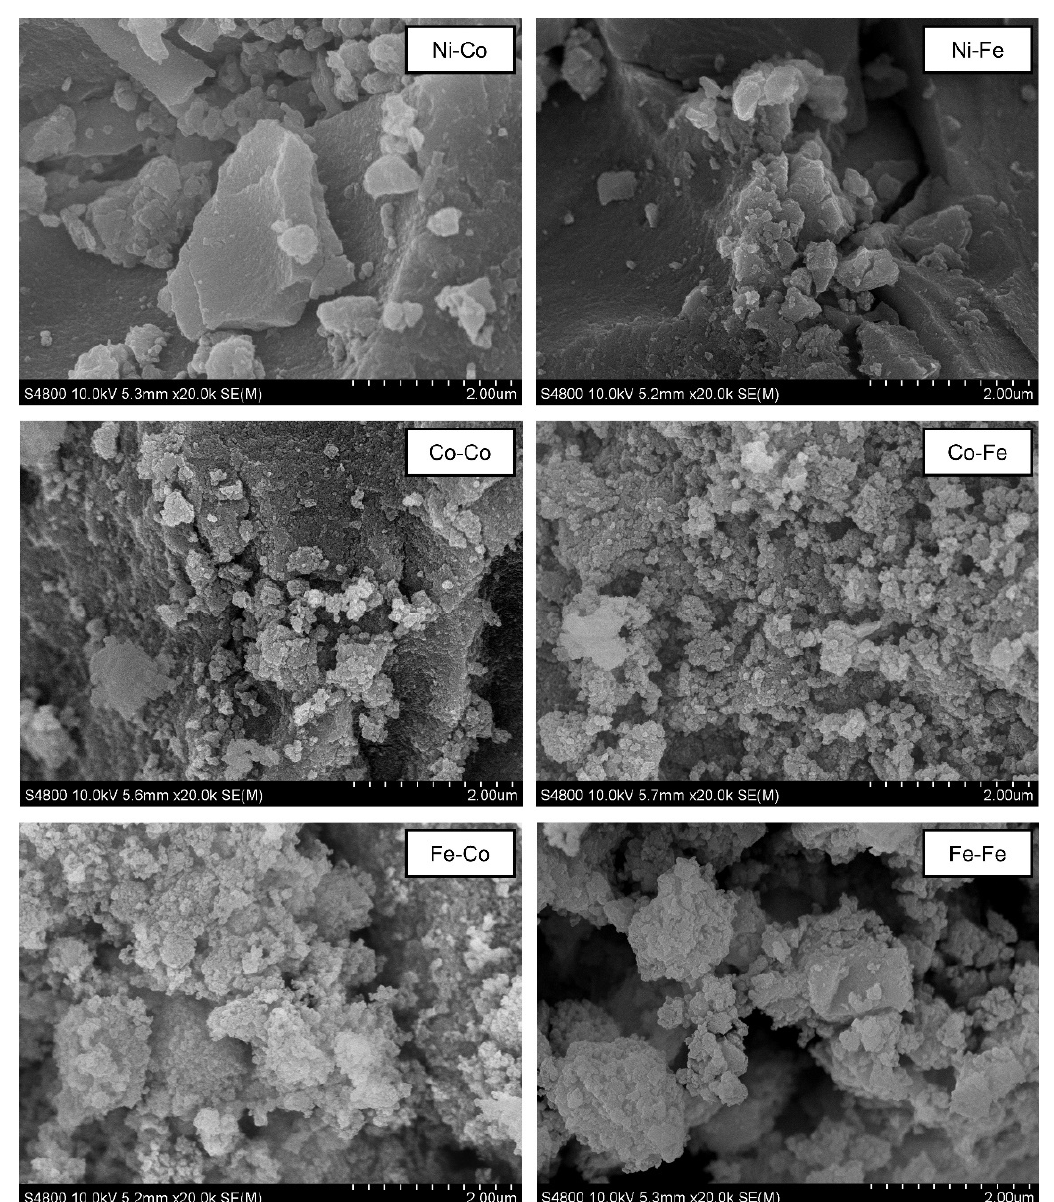
Figure 6. SEM images of the studied porous hexacyanometallates(III). The micropore capacity (V micro ) of the studied compounds was estimated by applying three different approaches (Table 7). There was huge variation when going from one method to another. The Dubinin–Asthakov (D-A) method resulted in the highest V micro , followed by t-plot and Rouquerol. Curiously, the smaller the micropore contribution, the greater the divergence between methods. Thus, it can be stated that determining micropore capacity by the employed methods is affected by the presence of